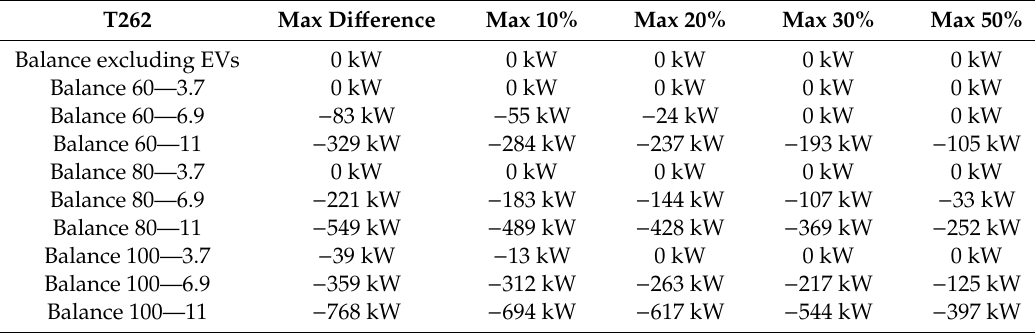
Table 6. E ff ect of flexible demand for Transformer T262.